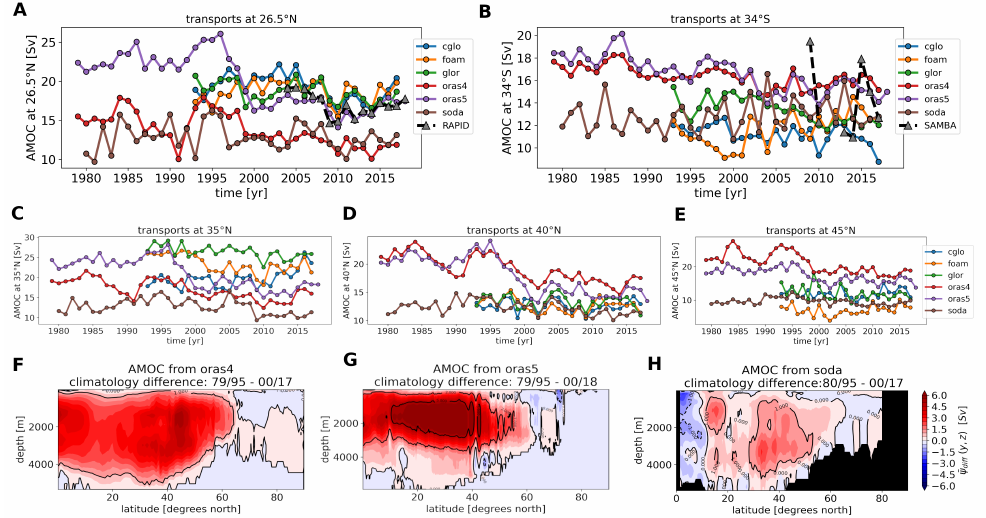
Figure 1. Time series of AMOC strength (i.e., maximum over depth of the streamfunction) at different latitudes: ( A ) 26.5° N, ( B ) 34° S, ( C ) 35° N, ( D ) 40° N, ( E ) 45°. Yearly data—RAPID and SAMBA data, which are shown as the triangles; GREP members are cglo in blue, foam in orange, glor in green, ORAS5 in purple, ORAS4 in red, and SODA in brown. Bottom panel: the difference between periods of stronger and weaker circulation for the ORAS4 ( F ) (contours mark 0, 1 Sv), ORAS5 ( G ) (contours mark − 1, 0, 1, 5 Sv), and SODA3.4.2 ( H ) (contours mark − 1, 0, 1 Sv) data on the entire northern cell of the overturning